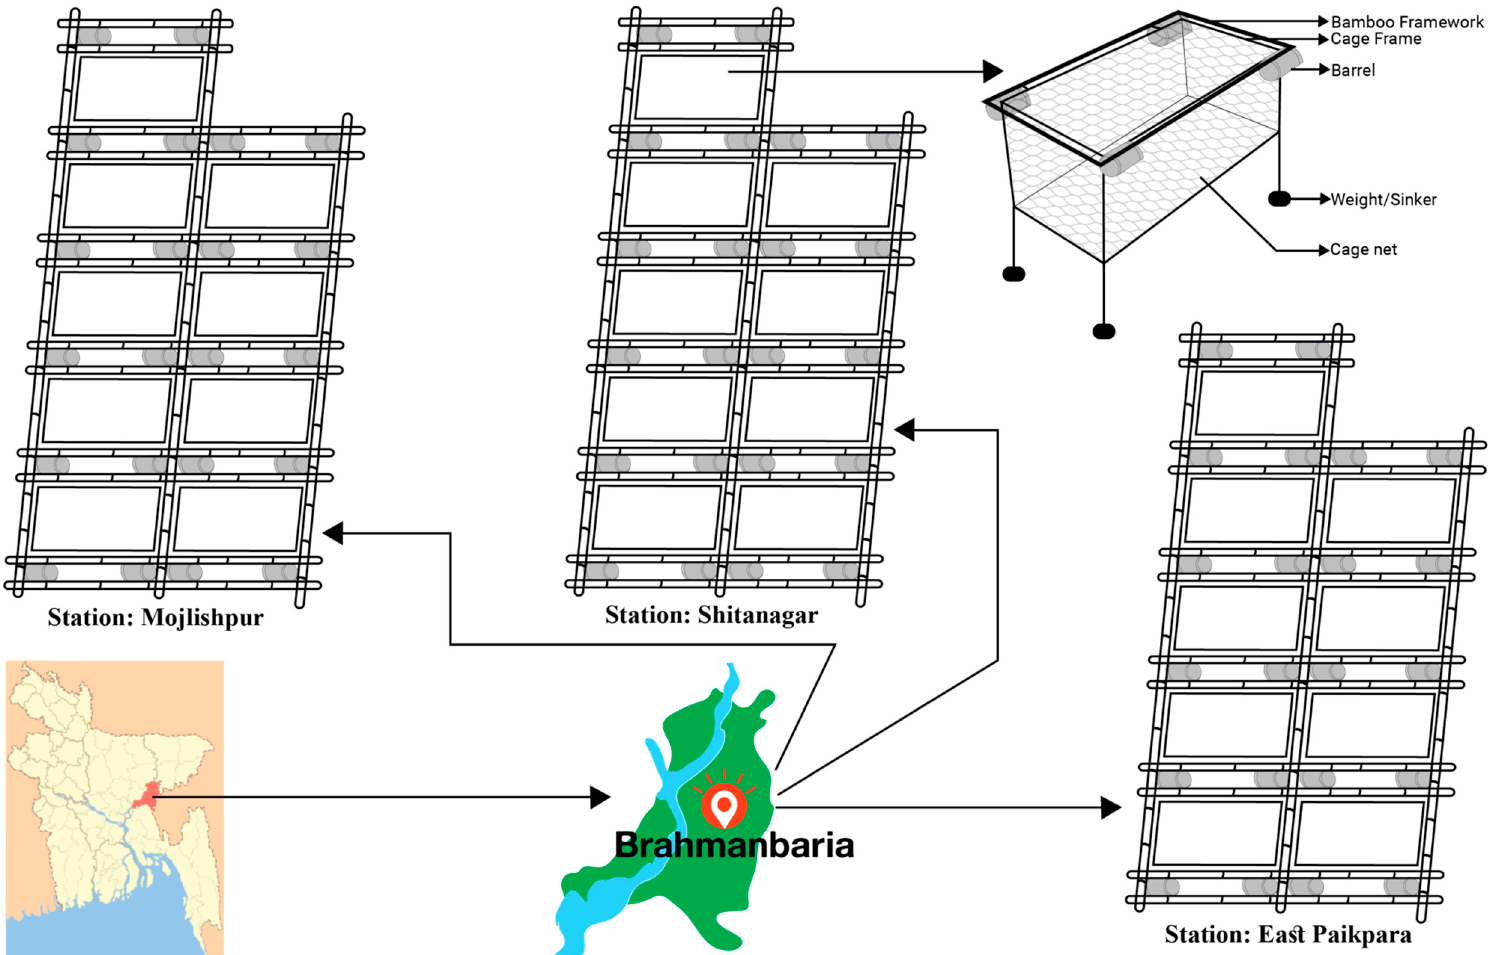
Figure 1. The study area of Nile Tilapia ( O. niloticus L.) under cage-culture system in Titas River of Bangladesh.